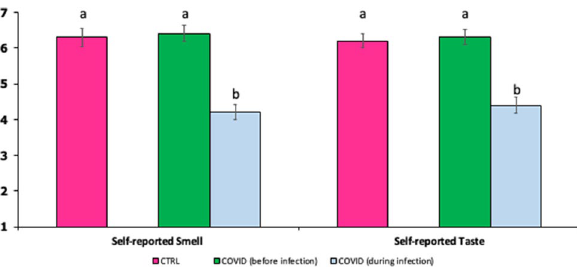
Figure 1. Mean intensity self-reported scores ± SEM of smell and taste functions of controls grouped by controls (CTRL, magenta bars) at the time of enrollment and cases (COVID) before (green bars) and during